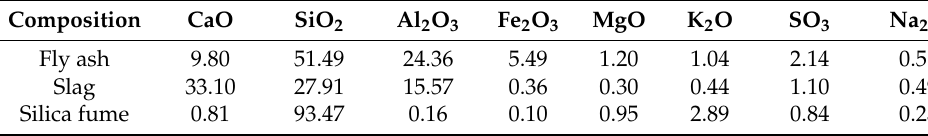
Table 1. Constituents of mineral admixtures as wt.%.